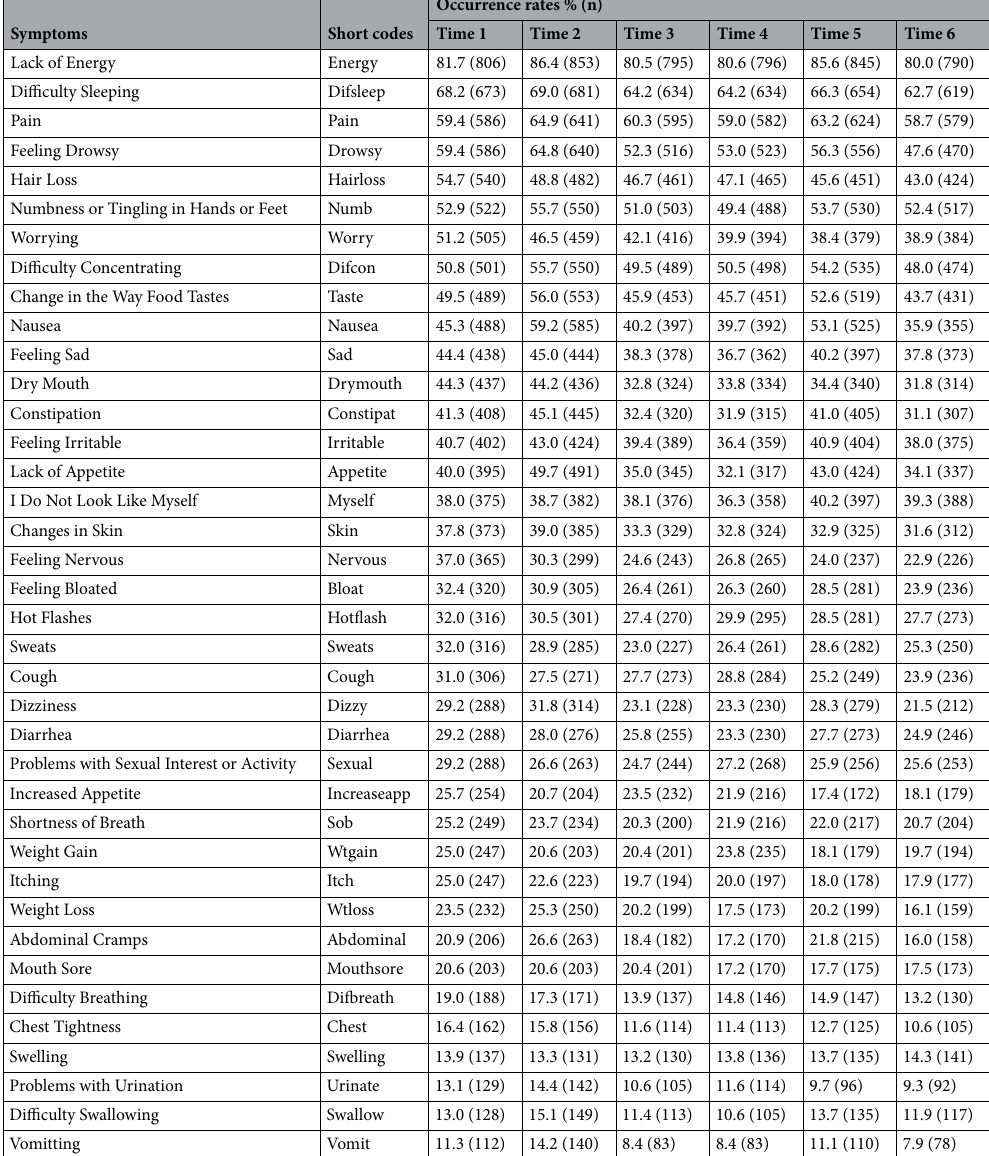
Table 2. 38 Cancer Symptoms, short codes, and symptom occurrence rates at the six time points.